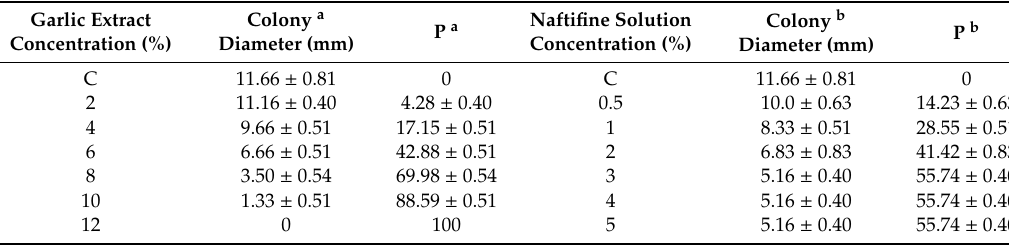
Figure 3. Colonies of M. guilliermondii on SDA: control ( A ); with garlic extract 4% ( B ); with garlic extract 8% ( C ); with garlic extract 12% (without colony) ( D ); with naftifine 0,5% ( E ); with naftifine 1% ( F ); with naftifine 3% ( G ); with naftifine 5% ( H ). Table 1. In vitro e ff ect of A. sativum extract and naftifine against M. guilliermondii isolate using the agar dilution method.